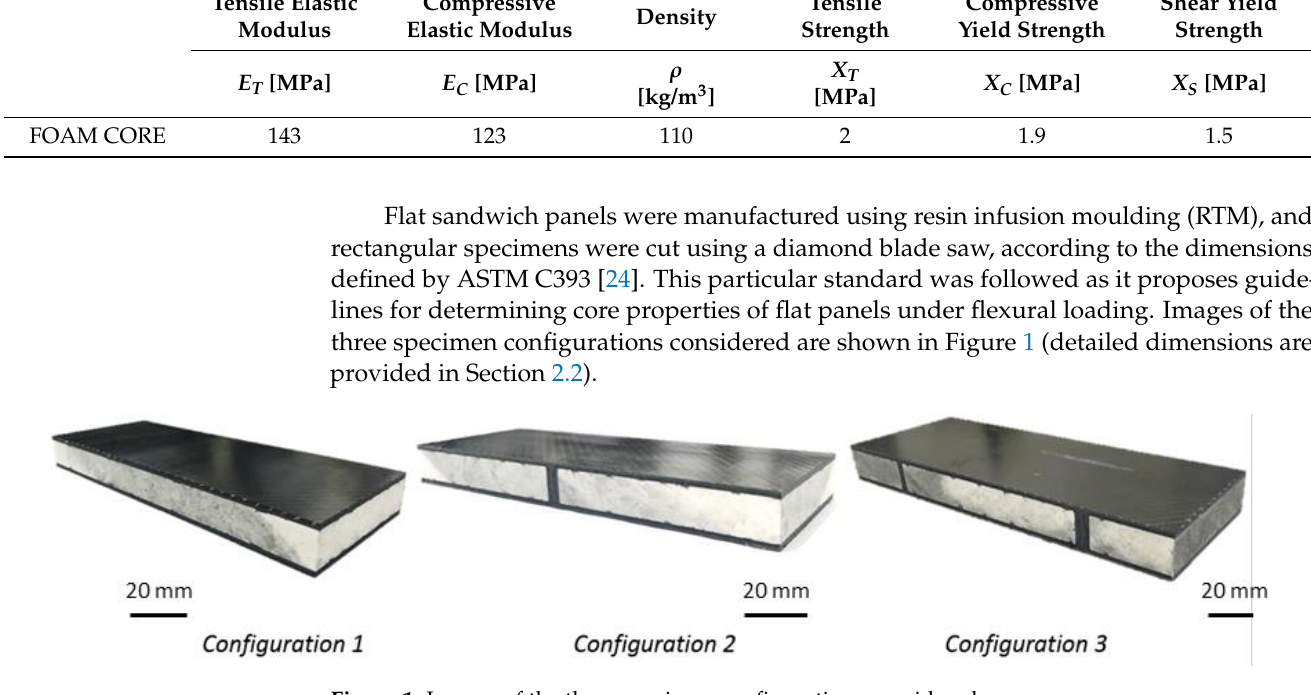
Figure 1. Images of the three specimen configurations considered.